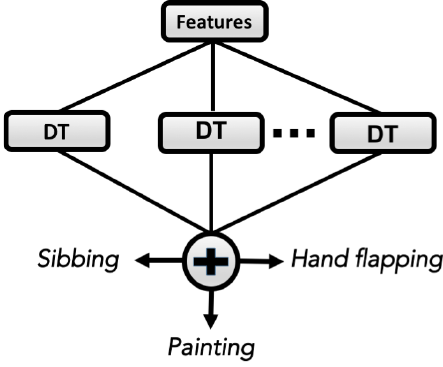
Figure 3. Schematic of the ensemble of decision trees (DTs) made by 40 DTs.